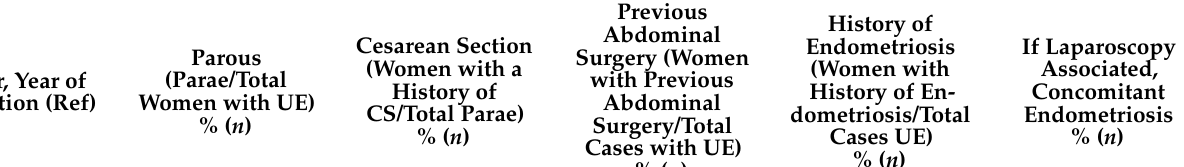
Table 2. Reproductive and endometriosis history of women with